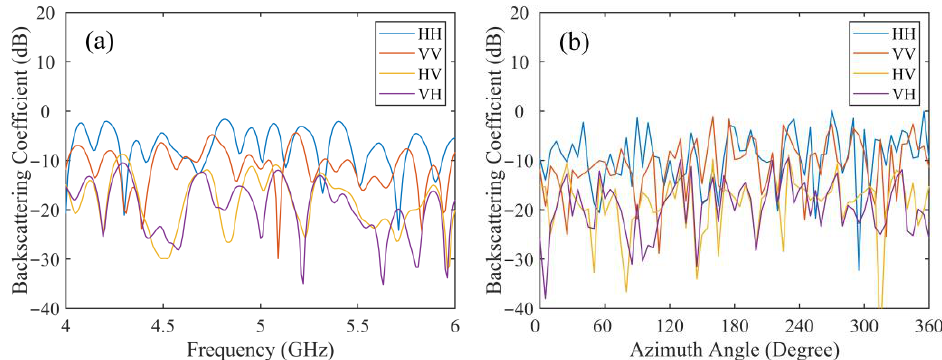
Figure 6. Measured backscattering coefficients of rice field Scene 2 as functions of ( a ) frequency and ( b ) azimuth angle. ( b ) azimuth